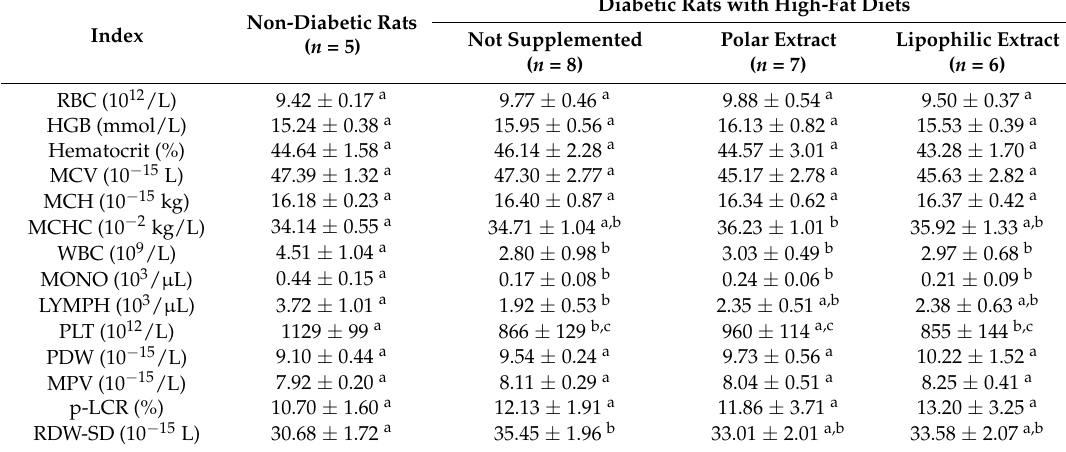
Table 5. Effects of dietary supplementation of elderberry polar and lipophilic extracts on the rats’ blood morphology and hematology indices. Diabetic rats without dietary supplementation and non-diabetic rats were also